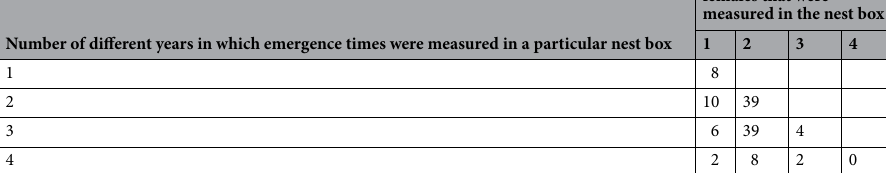
Number of different females that